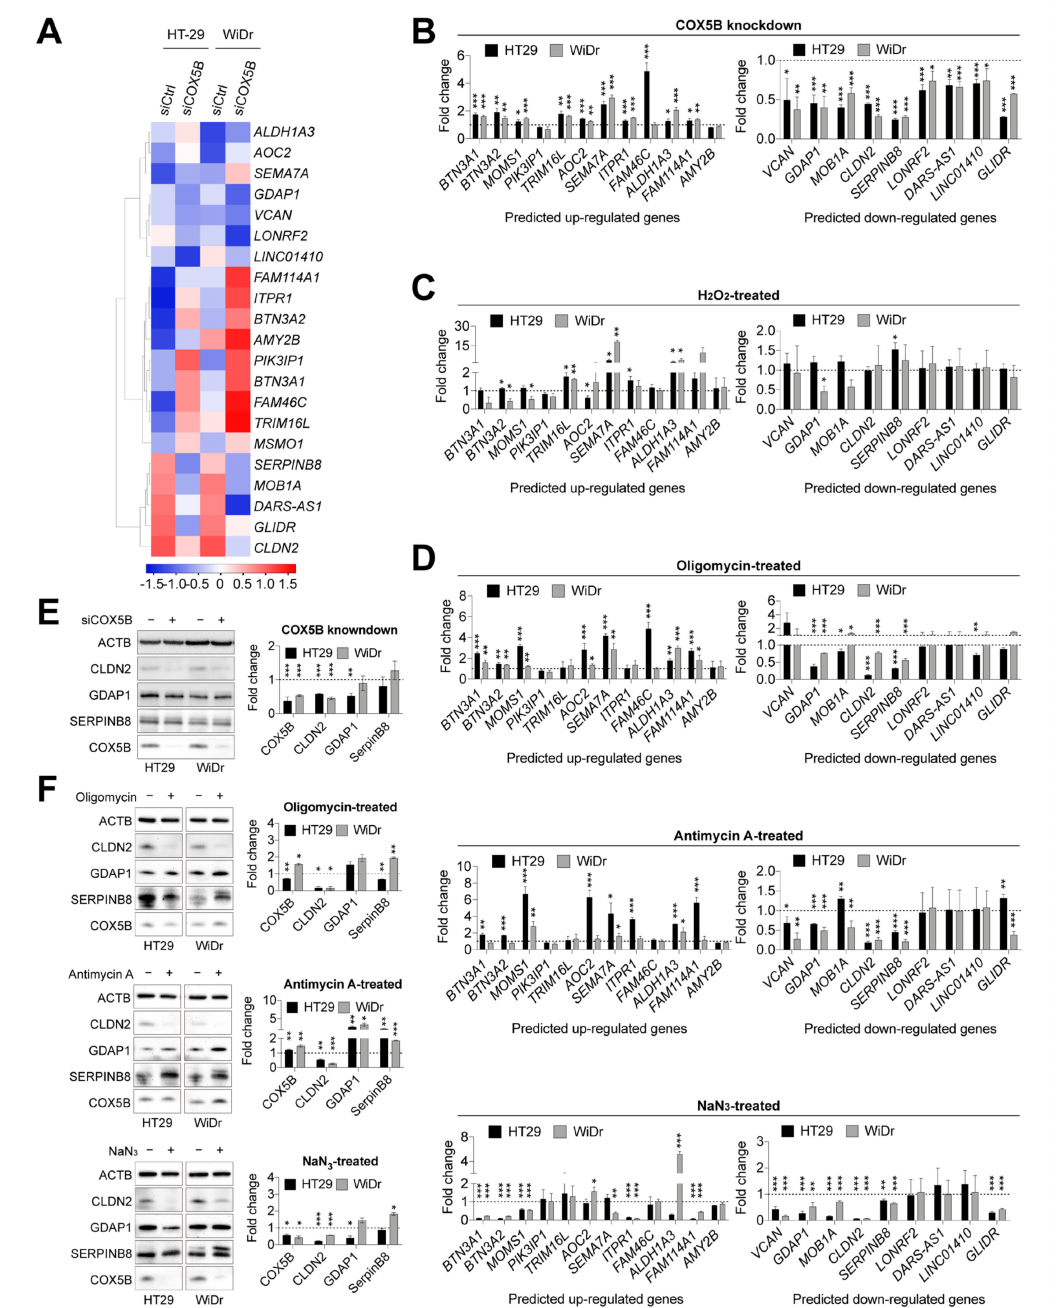
Figure 4. COX5B-mediated bioenergetic alterations orchestrates CLDN2 expression in CRCs cells. ( A ) The heat map representation of the relative expression of genes with log 2 -fold change > 0.5 and < − 0.5 in cells with silencing COX5B, when compared to cells with scramble siRNA. The average linkage method was used for hierarchical clustering. The distances between rows and columns were computed by Pearson method. RT-qPCR was performed for the validation of indicated genes expression under ( B ) depletion of COX5B, ( C ) H 2 O 2 treatment, and ( D ) treatment with OXPHOS inhibitors, including Oligomycin (upper), Antimycin A (middle), and NaN 3 (lower). Western blot analysis was conducted for examination of indicated protein expression under ( E ) depletion of COX5B and ( F ) treatment with OXPHOS inhibitors, including Oligomycin (upper), Antimycin A (middle), and NaN 3 (lower). − , cells without indicated treatment; +, cells with indicated treatment. *, p < 0.05; **, p < 0.01; ***, p < 0.001. All the p values were acquired by two-tailed paired Student’s t